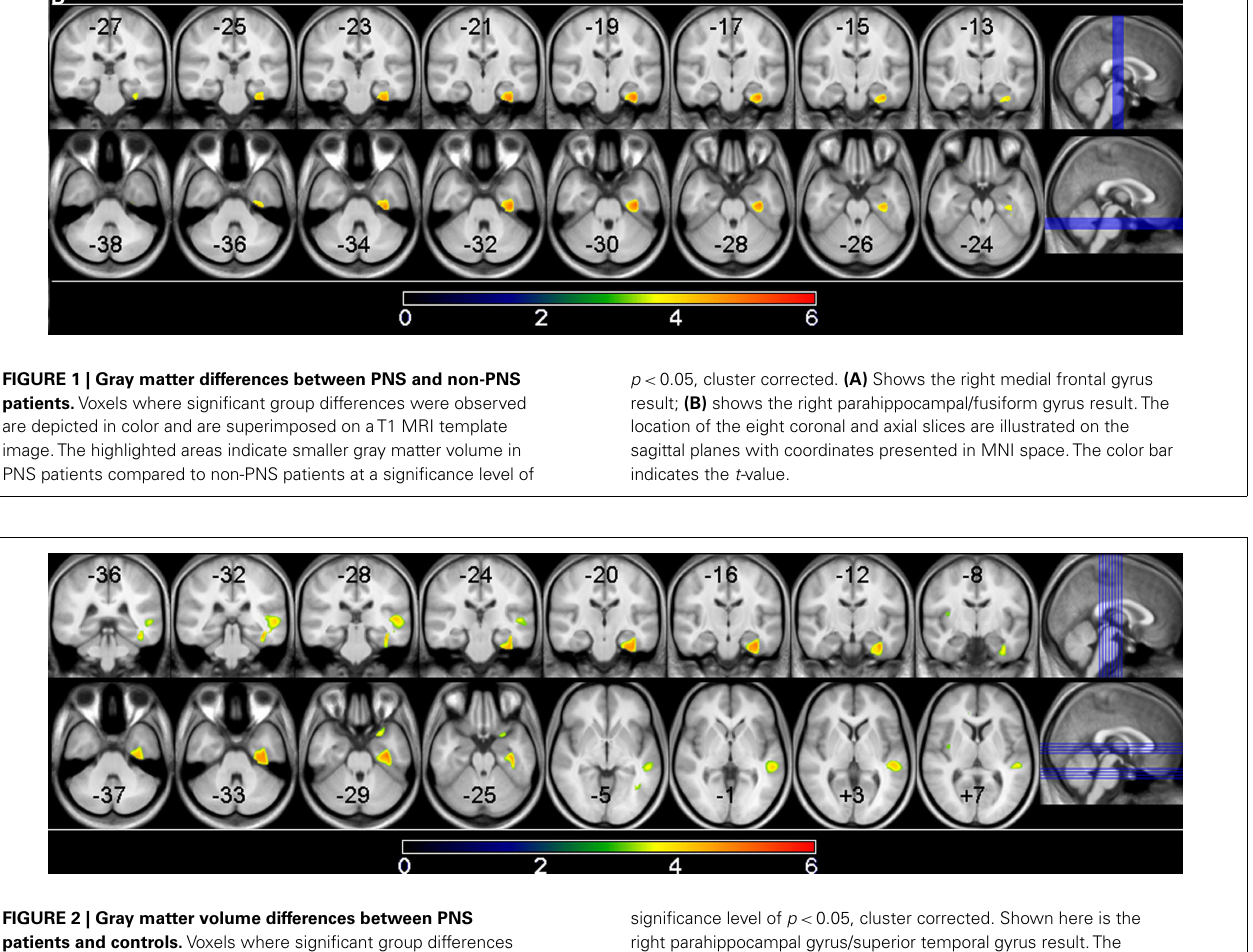
FIGURE 2 | Gray matter volume differences between PNS patients and controls. Voxels where significant group differences were observed are depicted in color and are superimposed on aT1 MRI template image.The highlighted areas indicate smaller gray matter volume in PNS patients compared to non-PNS patients at a